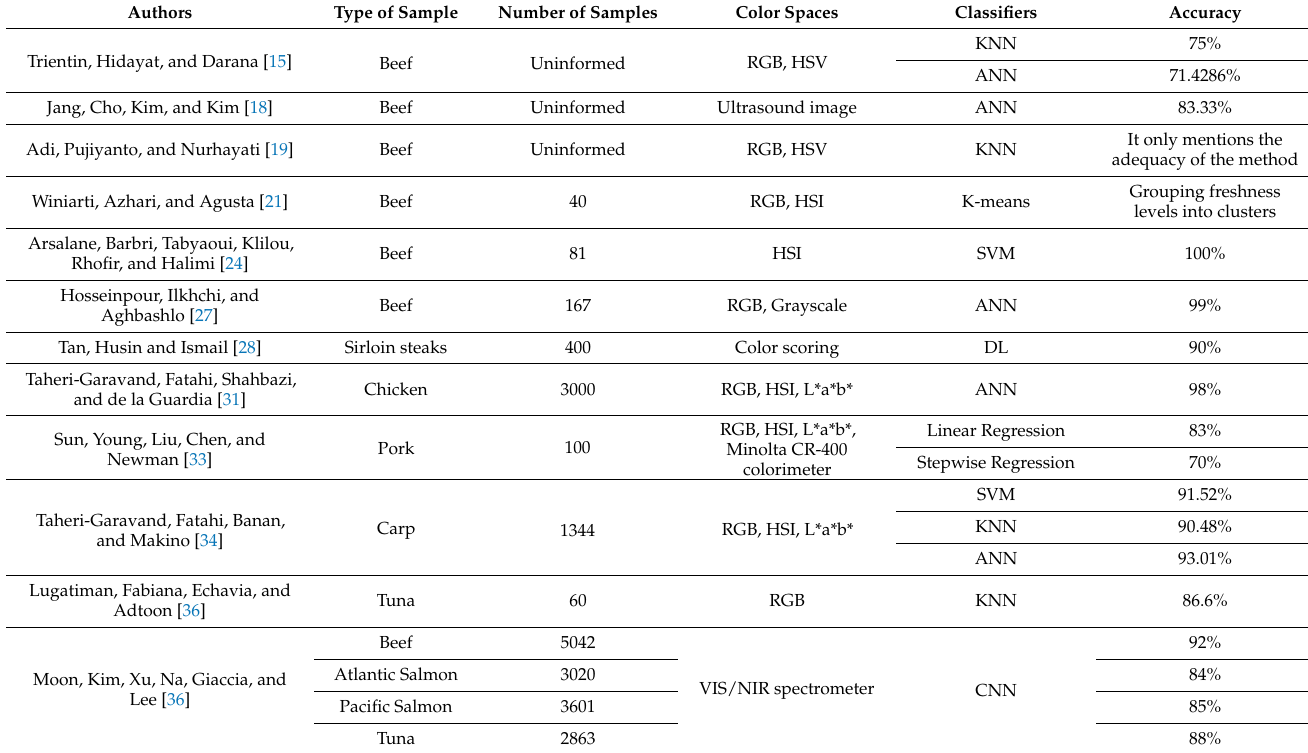
Table 1. Summary of studies on freshness classification of meat